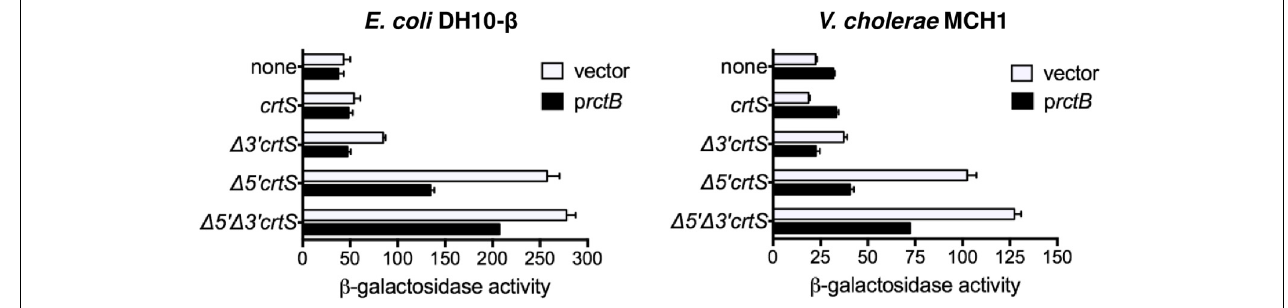
FIGURE 2 | The promoter within crtS ( P crtS ) is repressed by an unknown factor common to E. coli and V. cholerae. β -galactosidase activity in E. coli DH10- β (left) and monochromosome V. cholerae MCH1 (right), containing promoterless lacZ in a pBR-based plasmid (none, pMLB1109), or lacZ transcriptionally fused to either crtS (pBJH235), (cid:49) 3 (cid:48) crtS (pPC066), (cid:49) 5 (cid:48) crtS (pPC067) and (cid:49) 5 (cid:48) (cid:49) 3 (cid:48) crtS (pPC068). Additionally, the strains had a second plasmid, p rctB (pRR24, black bars) supplying RctB or the corresponding empty vector (pPC020, white bars). The x-axis in the two graphs are scaled differently. Both in E. coli and MCH1, the promoter activity dramatically increases upon deletion of the 5 (cid:48) crtS sequences. Since in both the strains the promoter repression is seen in the absence of RctB, the only factor known to bind crtS, an unknown factor common to two bacteria must be involved in repression of P crtS . Supplying RctB recovers the repression partially, which indicates that the promoter is normally repressed by RctB as well as the unknown factor. Error bars denote standard deviation of mean from three biological replicates.